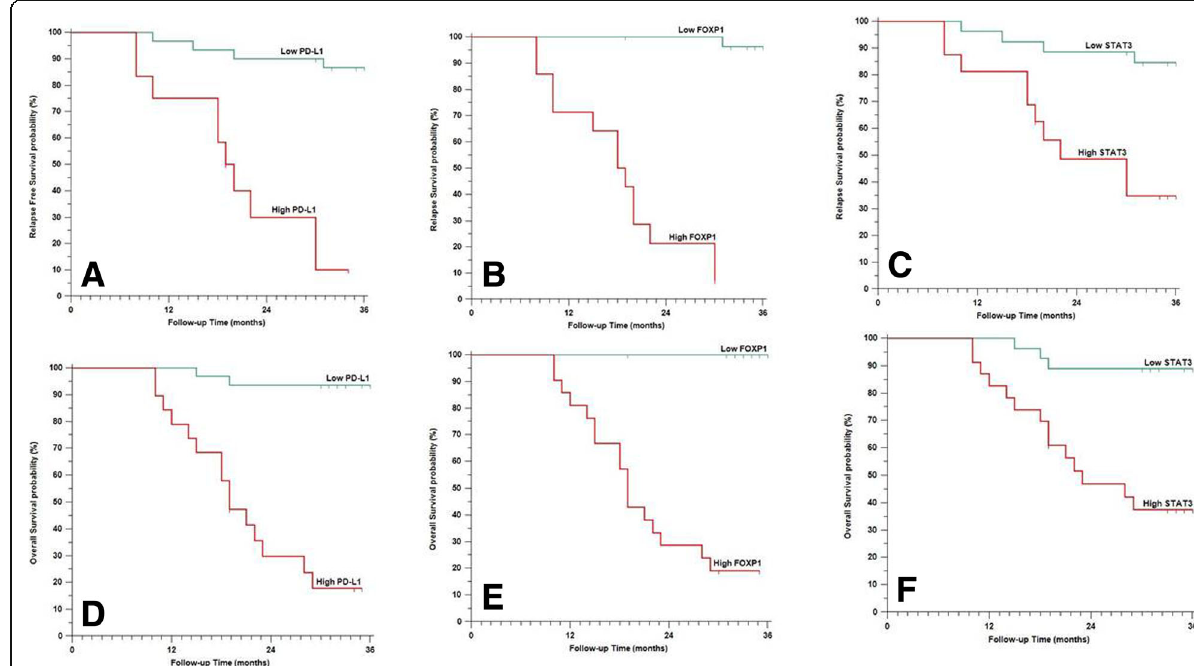
Fig. 4 Kaplan Meier plot ( a ) Relapse Free Survival Stratified by PD-L1, ( b ) Relapse Free Survival Stratified by FOXP-1 ( c ) Relapse Free Survival Stratified by STAT3. ( d ) Overall Survival Stratified by PD-L1, ( e ) Overall Survival Stratified by FOXP1 ( f ) Overall Survival Stratified by